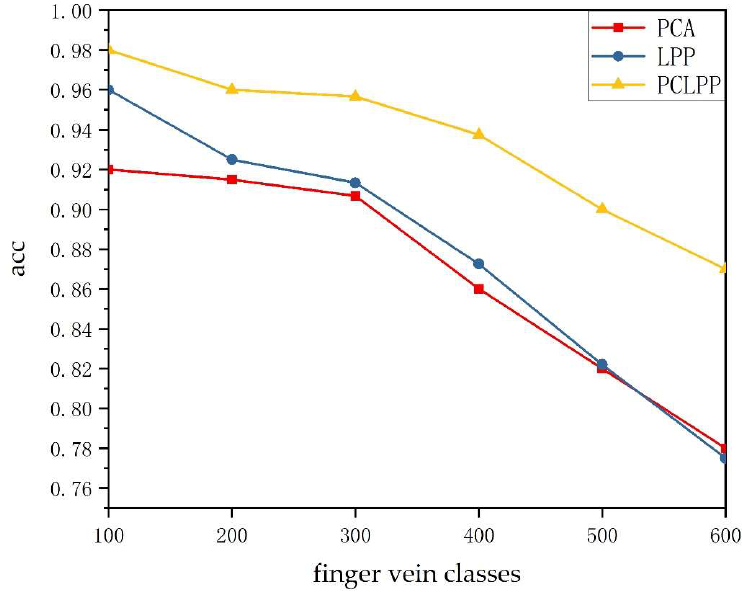
Figure 7. Image recognition rates for PCA, LPP, and PCLPP after adding “Salt and pepper” noise.